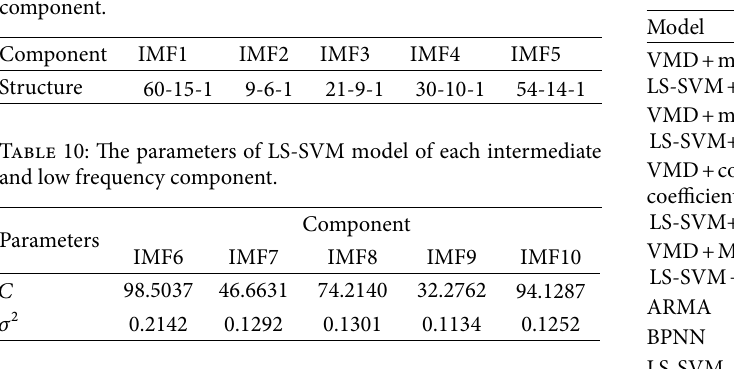
Table 11: Various model prediction